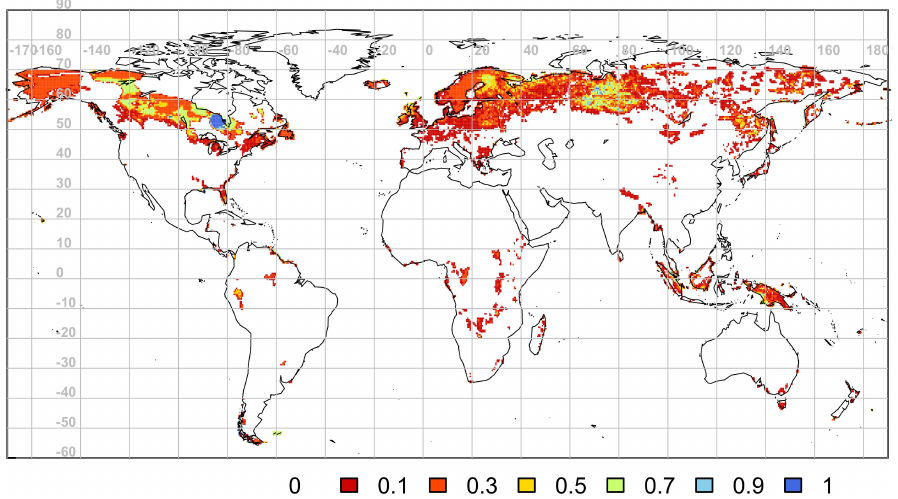
Figure 4. Fraction of Histosol area per 0.5 ◦ grid cell according to HWSD v.1.1.